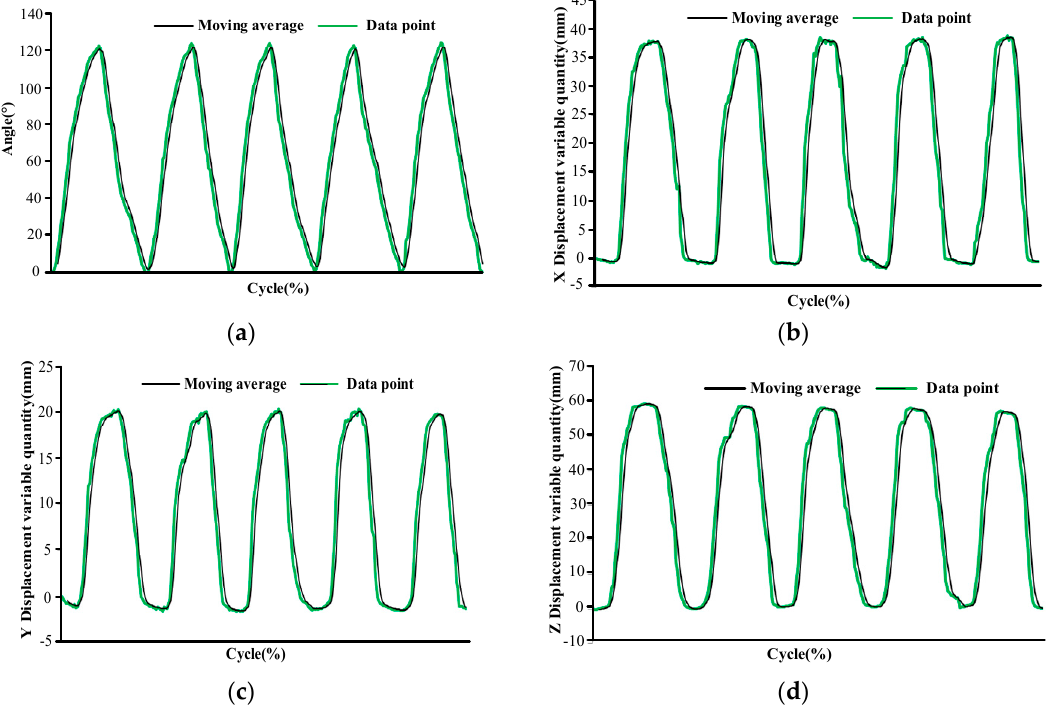
Figure 6. Diagrams of the glenohumeral (GH) joint motion information relative to the thorax coordinate system during humeral raising and lowering movements of five cycles in the sagittal plane: ( a ) humeral raising and lowering angle, ( b ) X-direction of the GH joint displacement variable quantity, ( c ) Y-direction of the GH joint displacement variable quantity, and ( d ) Z-direction of the GH joint center displacement variable quantity.